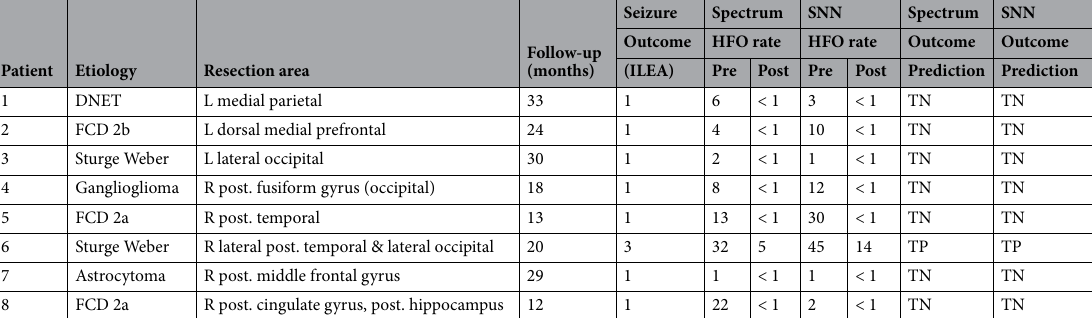
Table 2. Patient characteristics, HFO rates and postsurgical seizure outcome. We present the maximum HFO rates (HFO/min) in the pre- and post-resection ECoG as detected by the Spectrum detector 8 and the SNN detector. We “predict” seizure outcome for each patient based on whether remaining HFOs were observed in the post-resection recordings or not. We compare the “prediction” with the seizure outcome (ILAE).